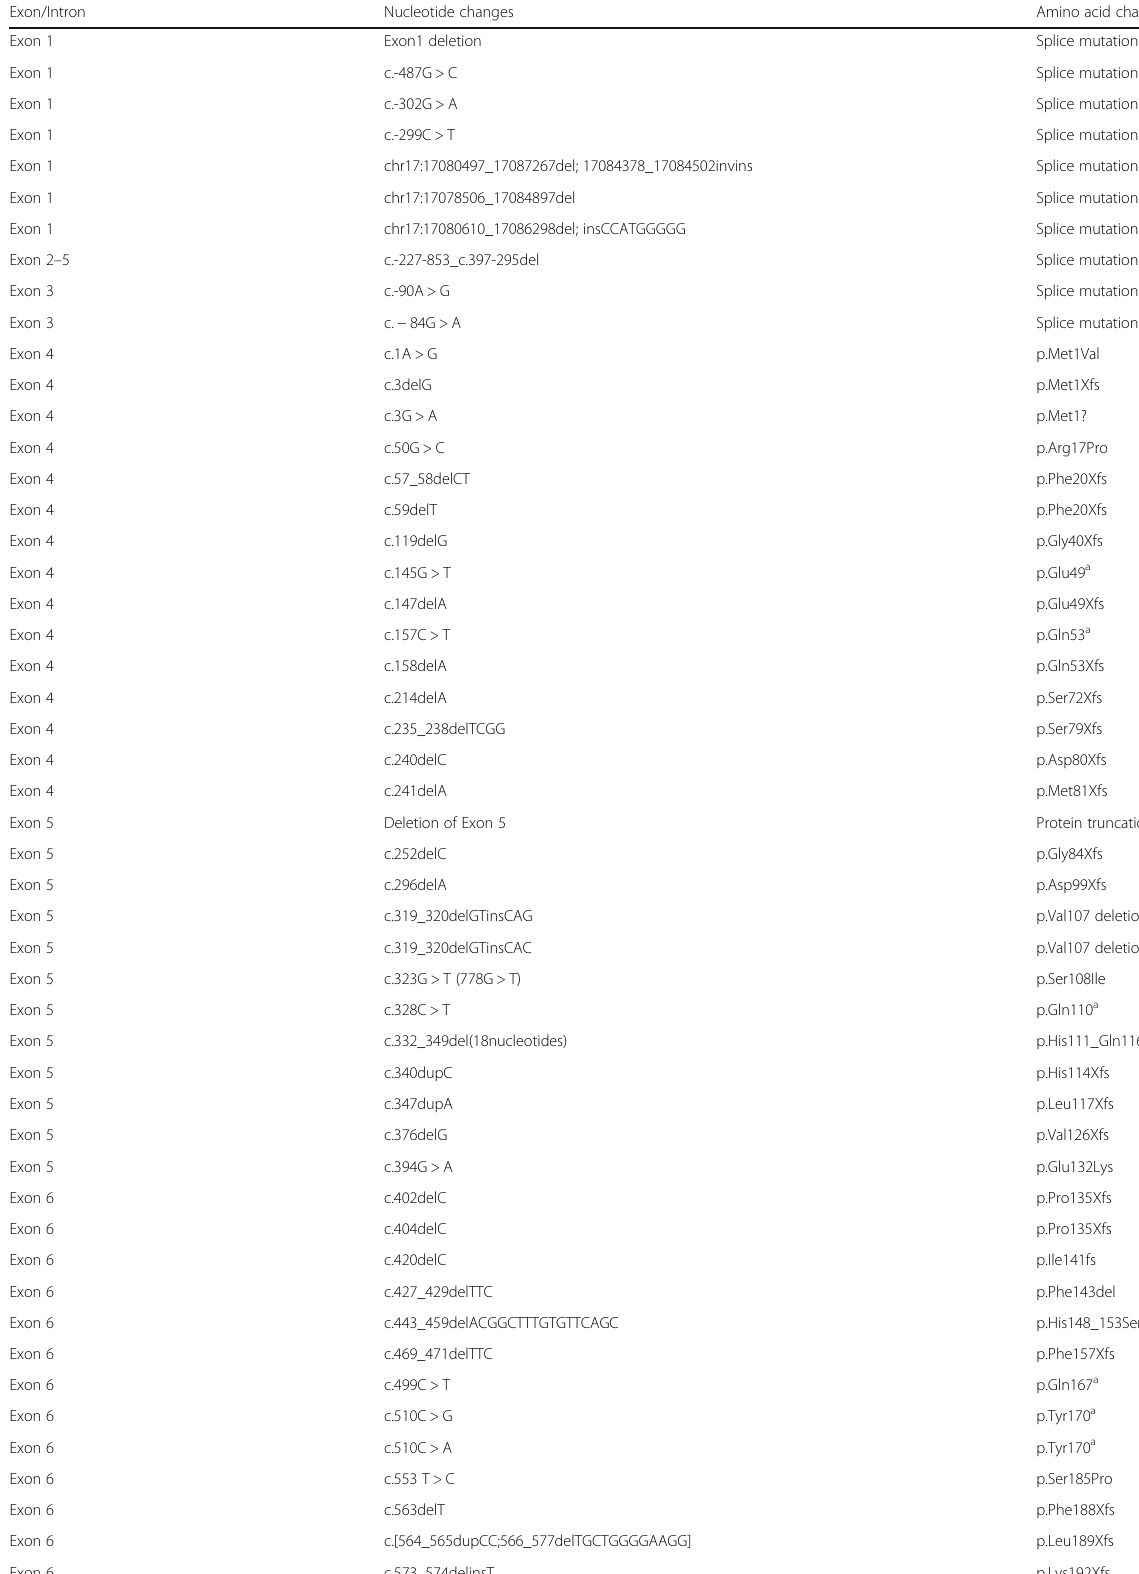
Table 1 Germline mutations in Birt-Hogg-Dubé